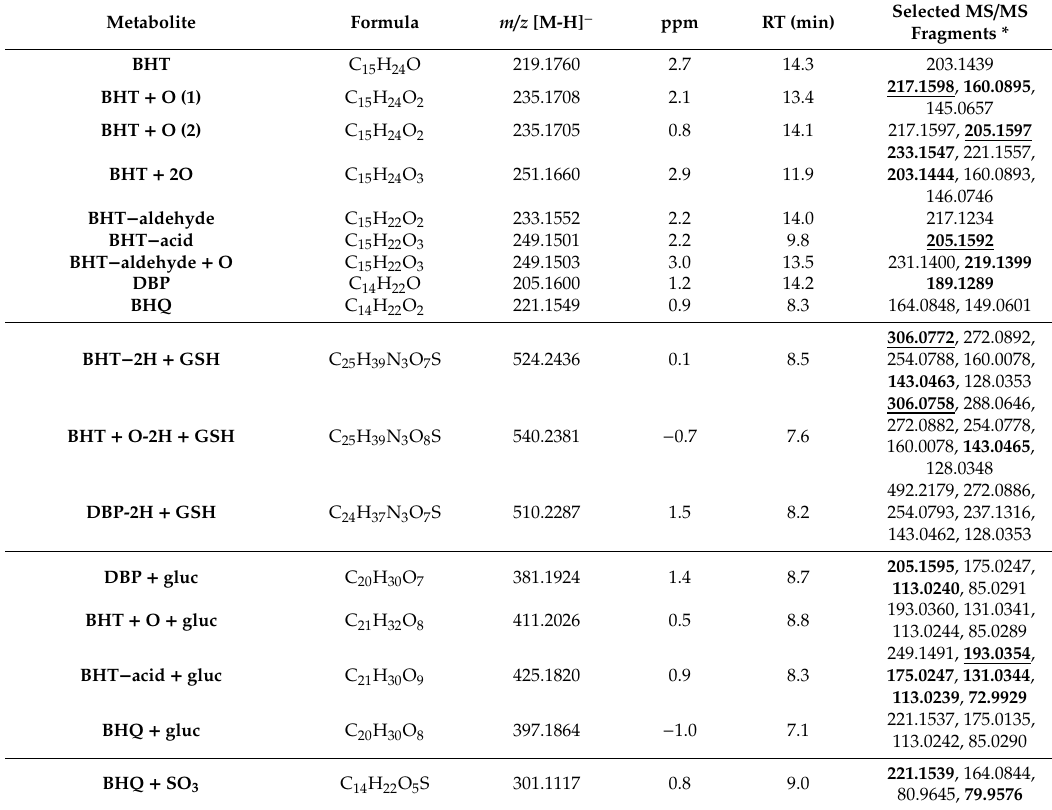
Table 1. Summary of MS / MS data for BHT and metabolites in negative ion